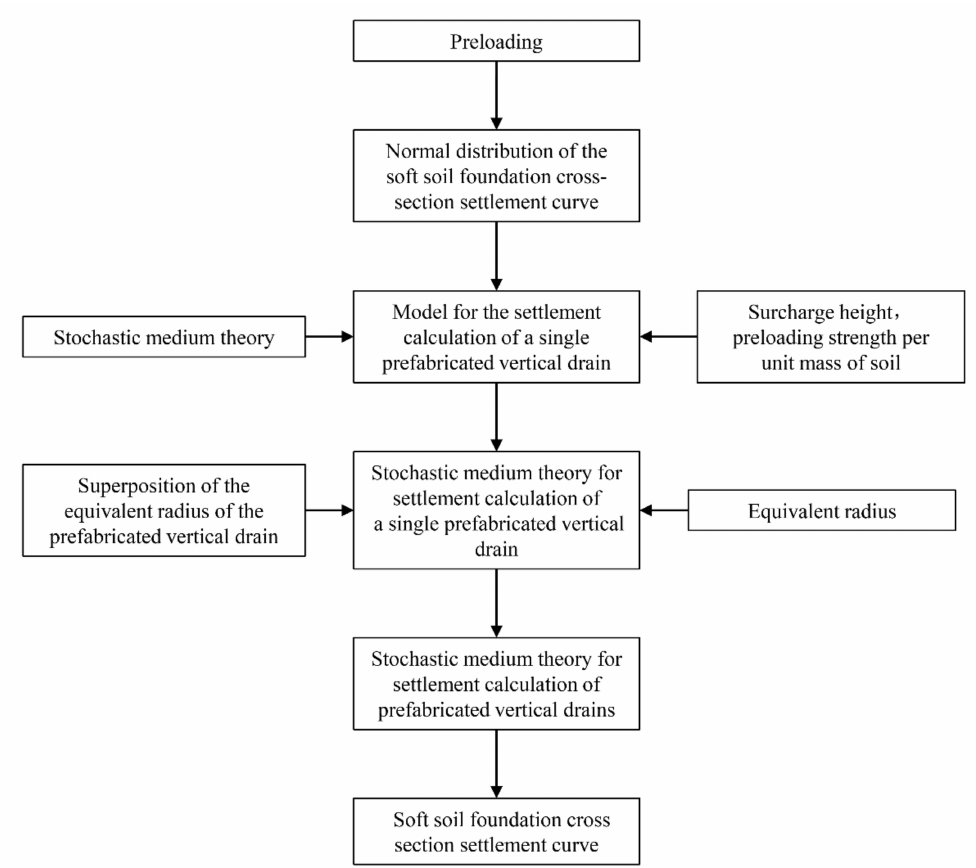
Figure 1. Flow chart of model